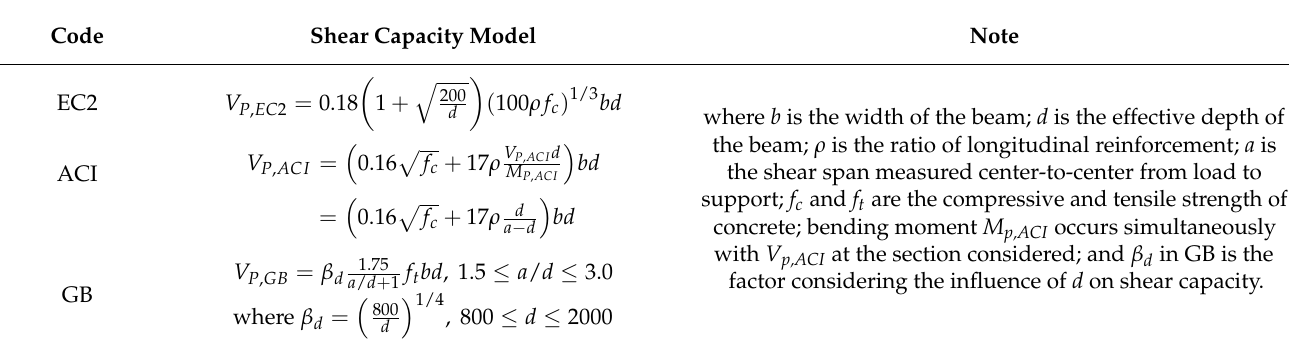
Table 1. Shear capacity models for RC beams without stirrups in the codes. Code Shear Capacity